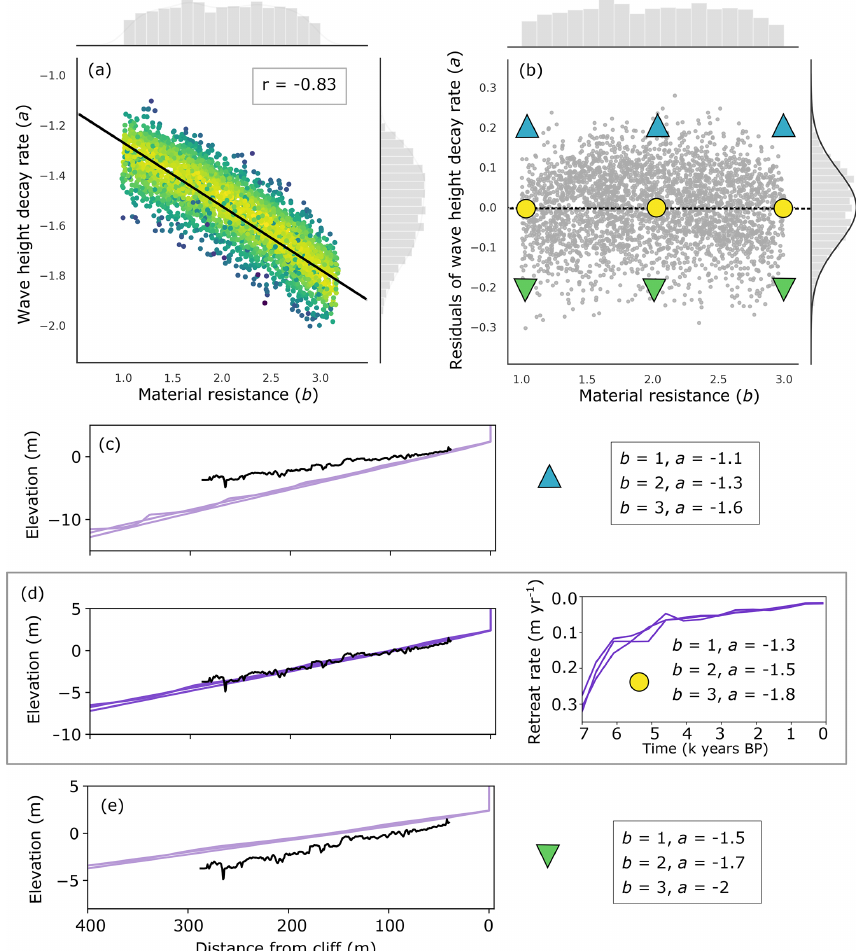
Figure 12. (a) Objective function space of accepted samples from the MCMC analysis for material resistance ( b ) and wave height decay rate ( a ) parameters for Bideford. A linear regression calculation was performed and is shown along with the r value of − 0 . 83. Histograms on either axis show the distribution of accepted sample points. (b) Residual plot from the regression line shown in (a) . Yellow circles plotted along the regression line in (b) correspond to model outputs shown in (d) that show the best-fit to the measured topographic profile. Green triangles pointing upwards (b) are plotted + 0 . 2 from the regression line and correspond to model outputs shown in (c) . Green triangles pointing downwards (b) are plotted − 0 . 2 from the regression line and correspond to model outputs shown in (e)